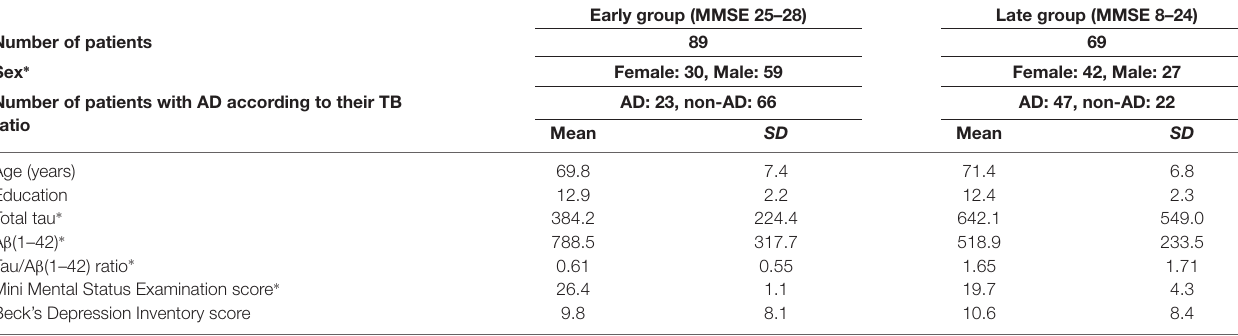
TABLE 1 | Demographic information and results of cerebrospinal fluid analysis for the patients’